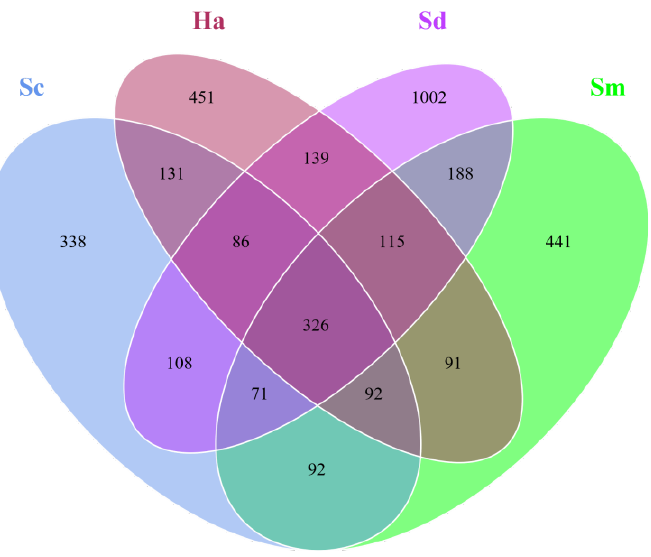
Figure 2. Venn diagram of core OTUs among the gut contents of S. monotuberculatus (Sm), S. chloronotus (Sc), H. atra (Ha) and the surrounding sediments (Sd).